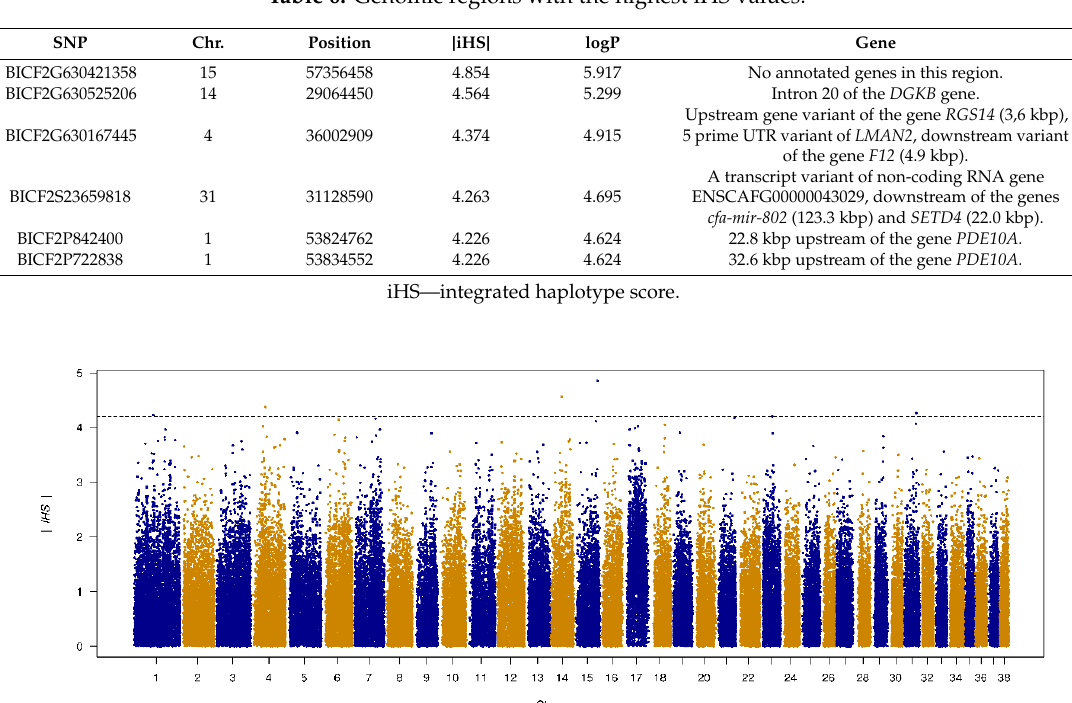
Table 6. Genomic regions with the highest iHS values.